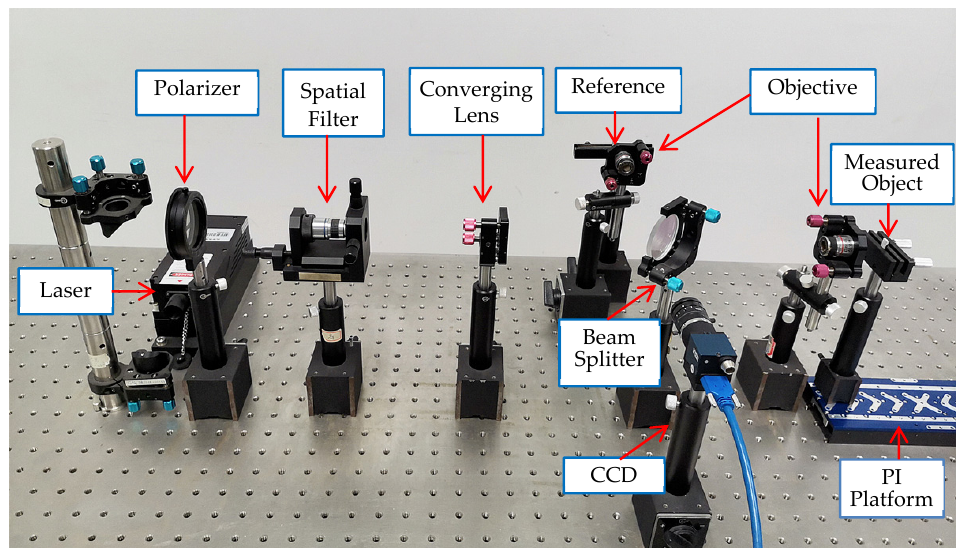
Figure 4. The schematic illustration of the experimental setup.